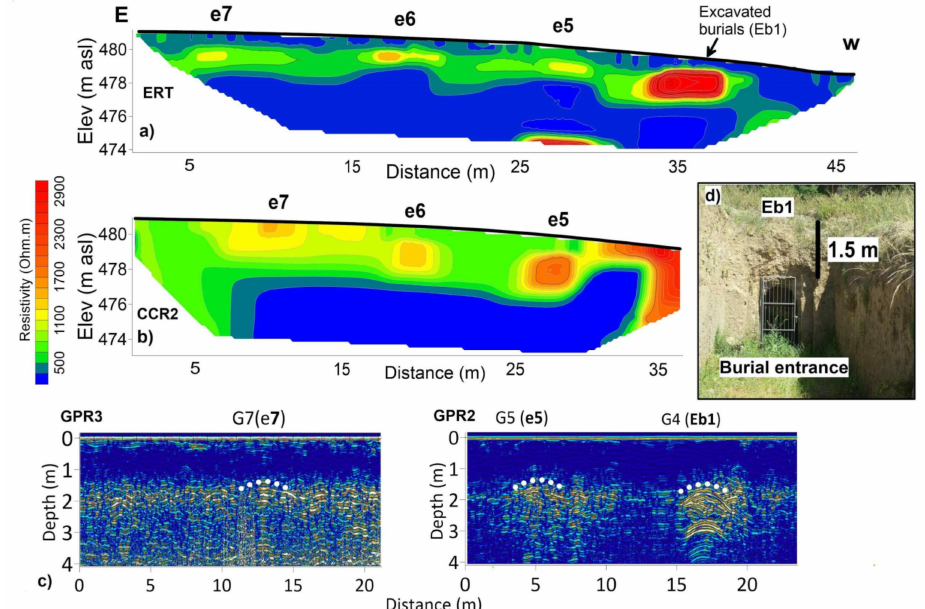
Figure 8. Geophysical data comparison. Comparison between all sets of output geophysical models recovered over a coincident line (CCR1, GPR2, GPR3, and ERT profiles in Figure 3). ( a ) ERT model and ( b ) image of the already excavated tomb Eb1. ( c ) CCR1 resistivity model. ( d ) GPR3 and GPR2 radargrams, wherein the dashed white lines mark the GPR anomalies attributed to the presence of the excavated (Eb1) and partially filled burials. The CCR and ERT profile topographies were extracted from a high-resolution digital surface